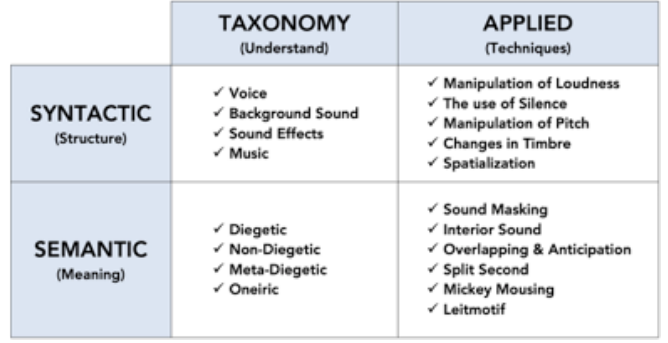
Figure 2: Film Sound Theory Concepts according to the